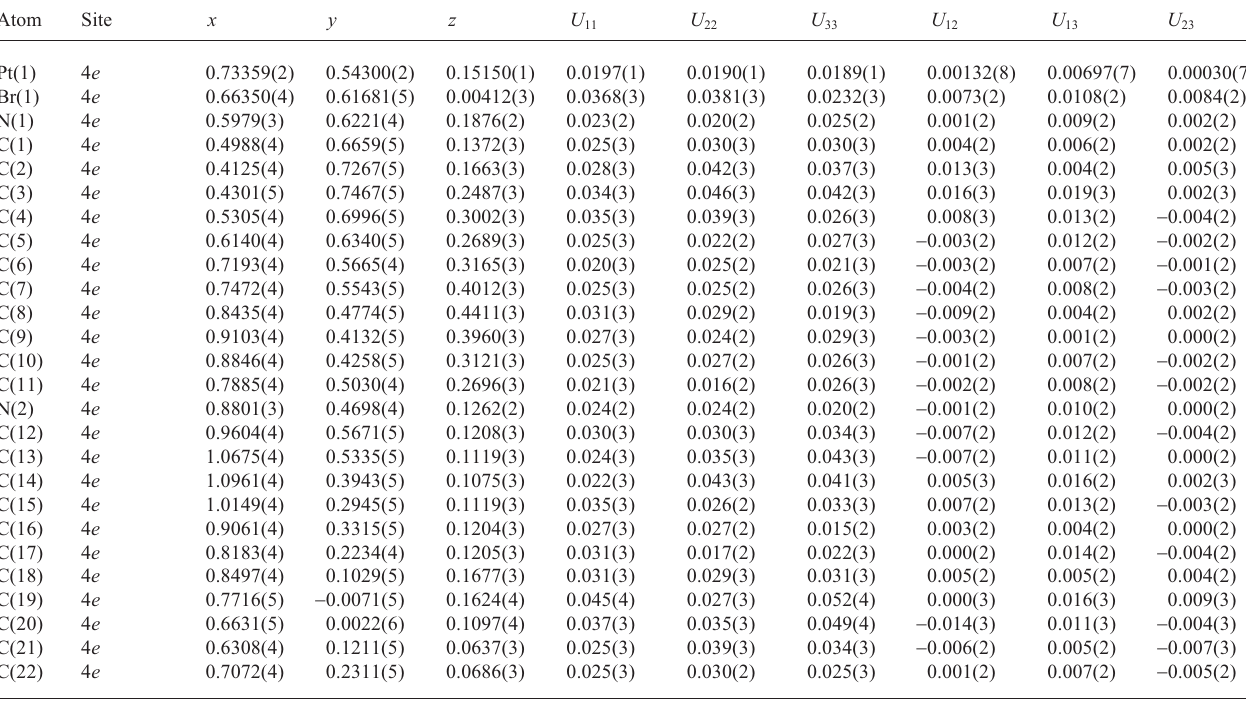
Table 3. Atomic coordinates and displacement parameters (in Å 2 ) .